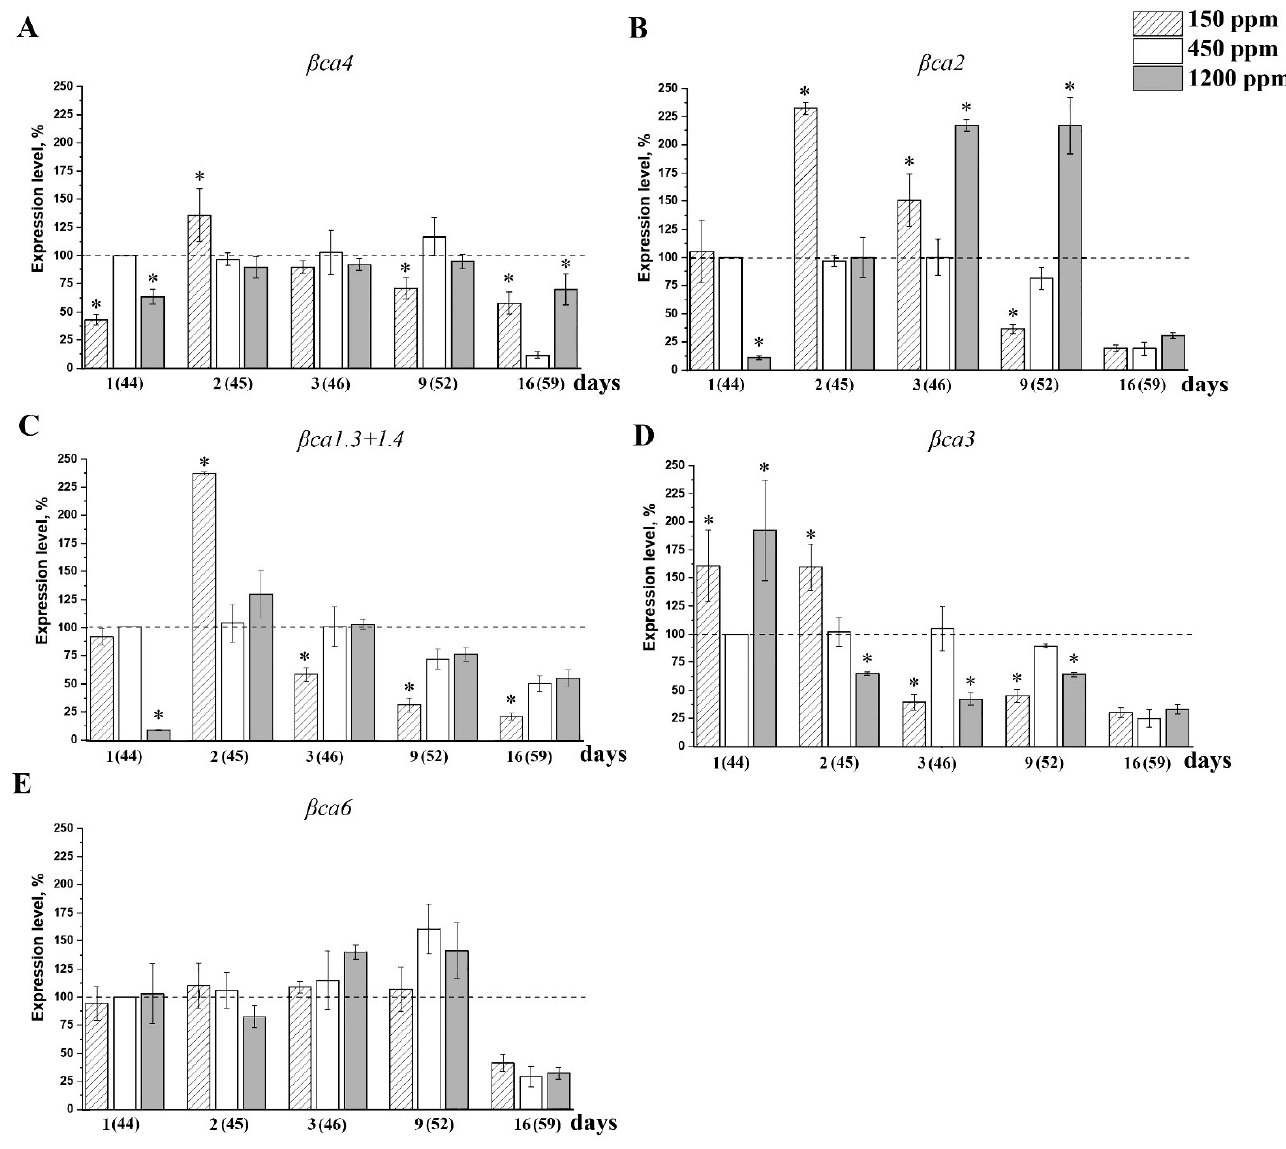
Figure 5. Levels of expression of genes encoding extrachloroplast carbonic anhydrases in Arabidopsis plant leaves after introduction to low (150 ppm), and high (1200 ppm) CO 2 levels in the air. Numbers on the X axis show the age of the plants and (in parentheses) the number of days after moving introduction of the plants of 43 days of age grown at the atmospheric CO 2 level (450 ppm) to conditions of changed CO 2 level in the air. The 100% value (dashed horizontal line) is the expression level of the corresponding genes encoding CAs in the plants of 44 days of age grown at 450 ppm (Table 2). Data are shown as mean ± the SE. The experiments were performed three times with similar results. ( A )— βca4 ; ( B )— βca2 ; ( C )— βca1.3+1.4 ; ( D )— βca3 ; ( E )— βca6 . Asterisks denote statistically significant differences between values for different CO 2 levels on the same experimental day, p < 0.01.